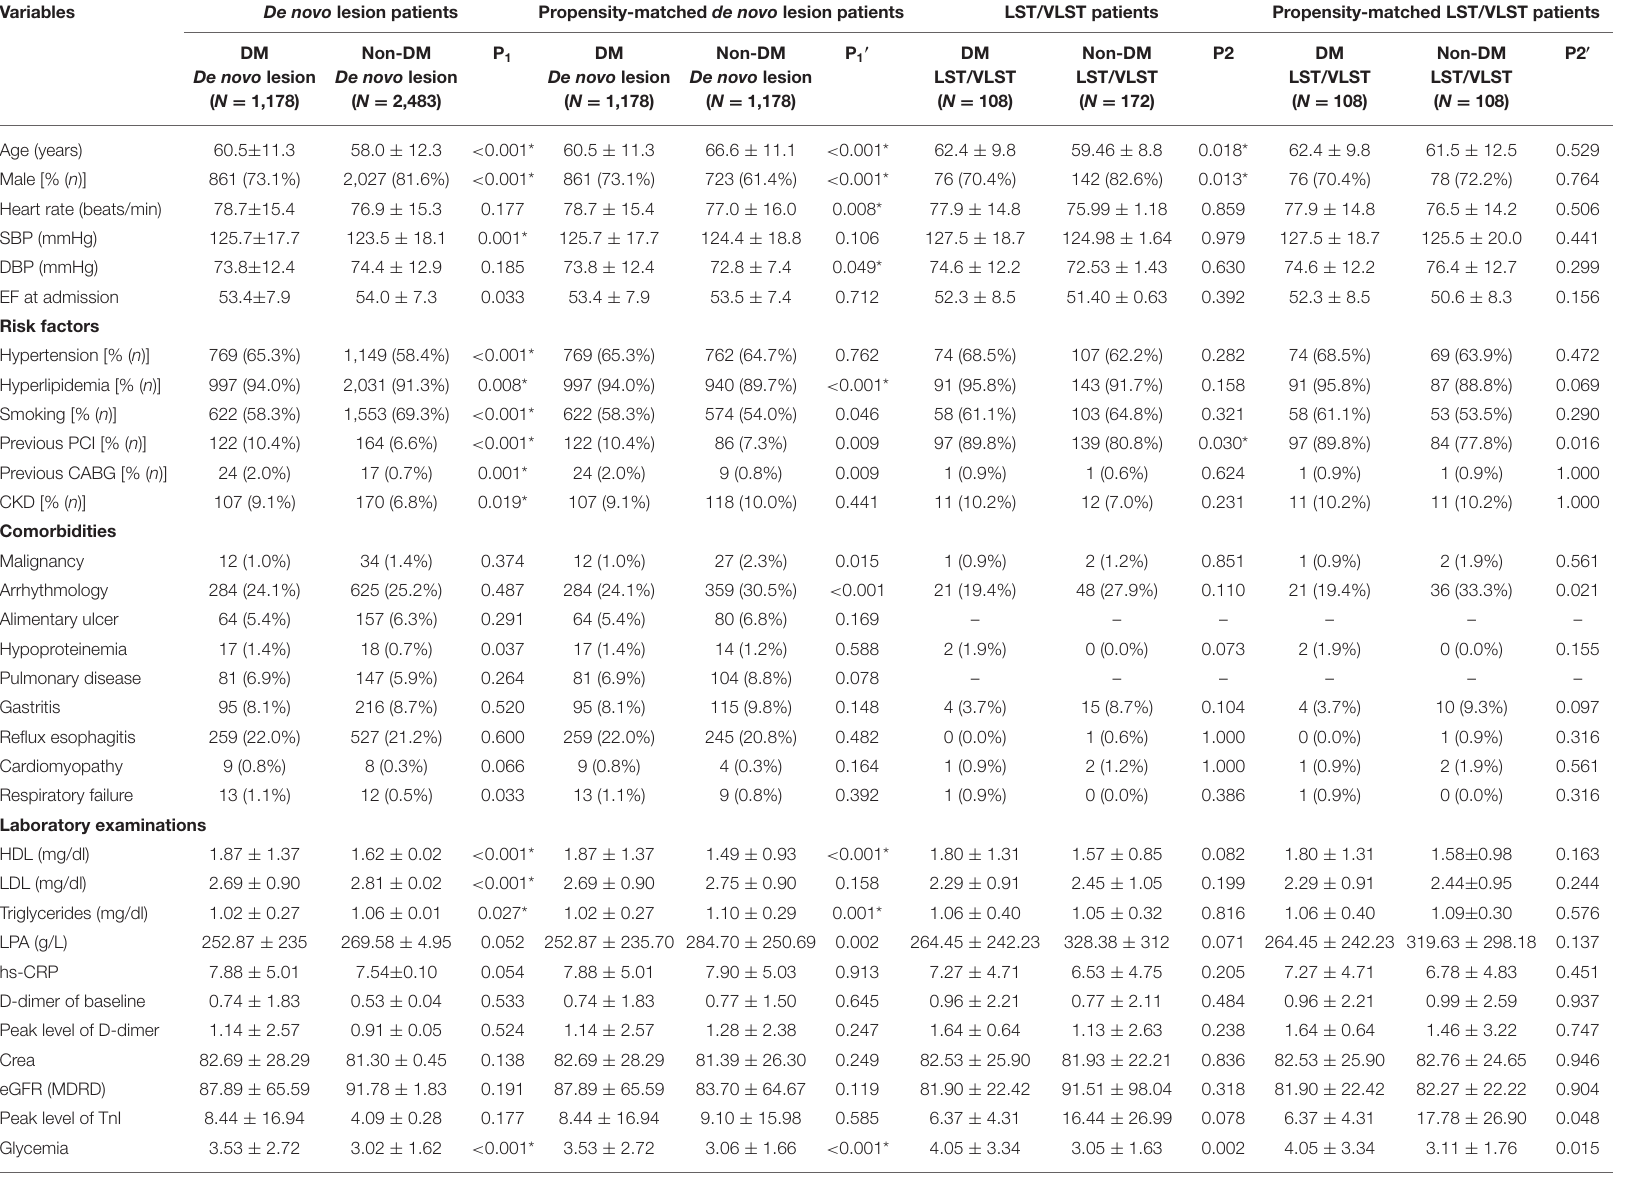
TABLE 1 | Baseline characteristics of entire